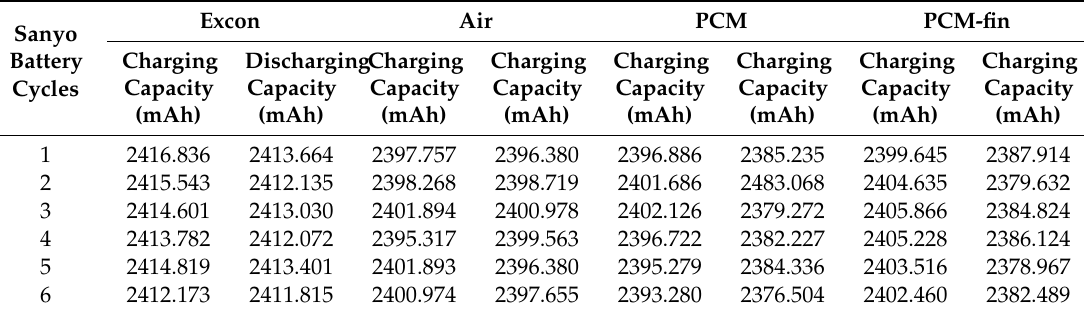
Table 4. Capacity curve of Sanyo LIB in charge and discharge cycles.